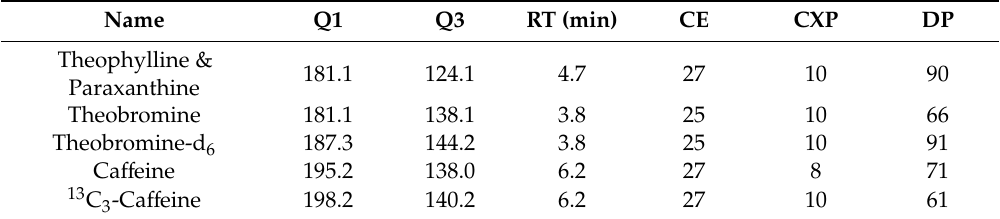
Table 5. Multiple reaction monitoring (MRM) transitions of the data acquisition method for ca ff eine, theobromine, theophylline and paraxanthine, and the internal standards 13 C 3 -ca ff eine and theobromine-d 6